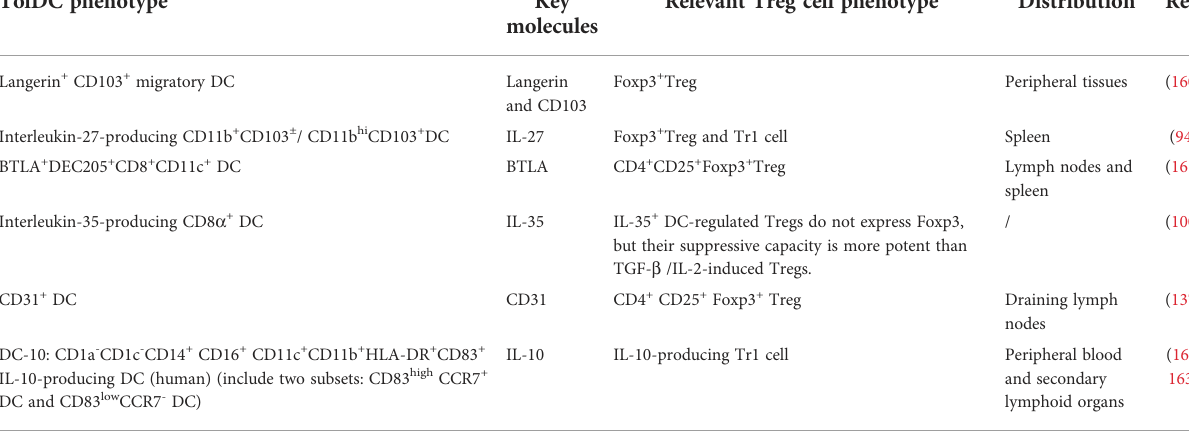
TABLE 3 Potential tolDC subsets that can induce Treg